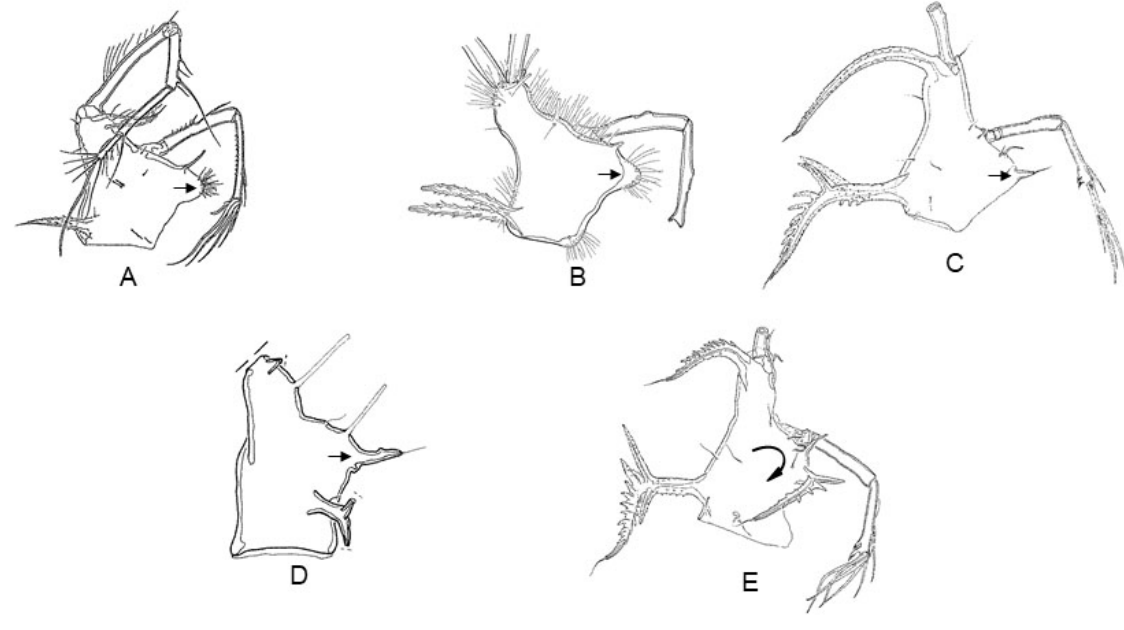
Fig. 16. Lateral view of the cphth. A . Arthuricornua anendopodia Conroy-Dalton, 2001. B . Dorsiceratus sp. (DIVA 1, #346/8-8). C . Ceratonotus thistlei Conroy-Dalton, 2003. D . Poropsyllus menzelae gen. et sp. nov. E . Dendropsyllus thomasi Conroy-Dalton, 2003. No scales. Arrows indicate the position and direction of the CVEa (A–B) and CLVPa (C–E). A modified from Conroy-Dalton (2001); B, D originals; C, E modified from Conroy-Dalton